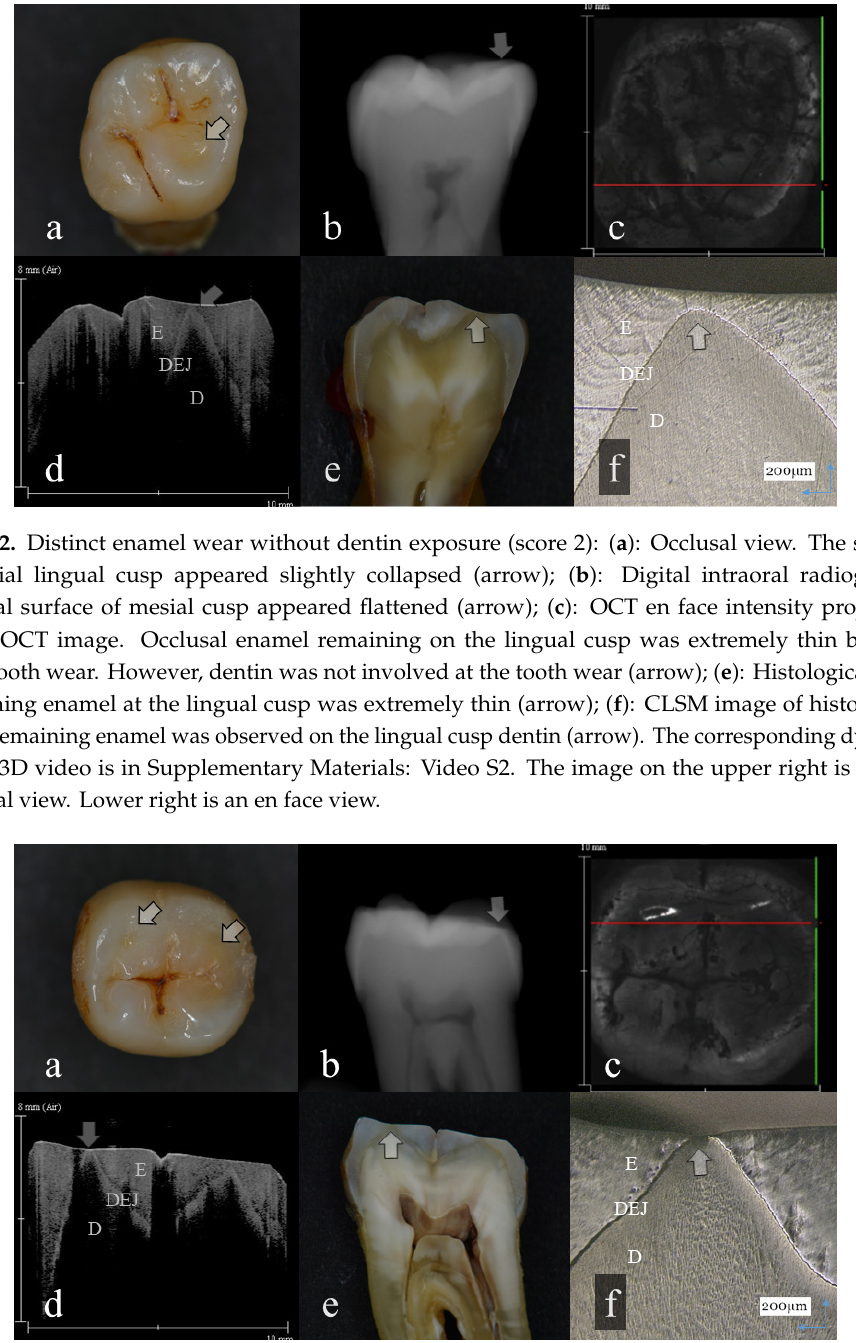
Figure 4. Tooth wear with slight dentin exposure (score 3); ( a ): Occlusal view. Occlusal cusps were flattened. The middle of the cusp was collapsed showing the small dent (arrow); ( b ): Digital intraoral radiography. Remaining enamel thickness of all the tooth crown was extremely reduced (arrow); ( c ): OCT en face intensity projection; ( d ): SS-OCT image. Occlusal enamel was worn, showing the flattened surface. Loss of enamel reached to the DEJ with slight dentin exposure (arrow). The brightness of the exposed dentin surface was increased, suggesting dentin demineralization (arrow); ( e ): Histological view. Enamel thickness for all the tooth crown was thin. Occlusal tooth wear involved slight dentin exposure (arrow); ( f ): CLSM image of histological view. Slight dentin exposure at the cusp was observed (arrow). The corresponding dynamic slicing 3D video is in Supplementary Materials: Video S4. The upper right is a cross sectional view. Lower right is an en face image.